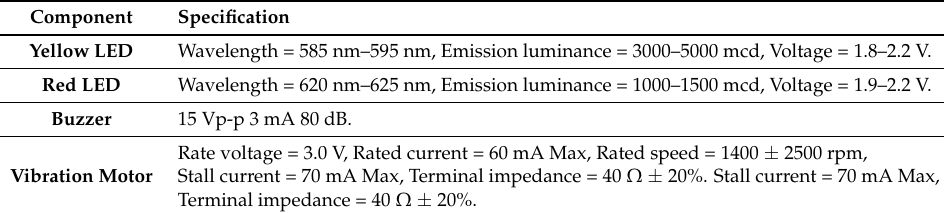
Figure 15. Implementation framework of early warning module. Table 4. Specification of alarm